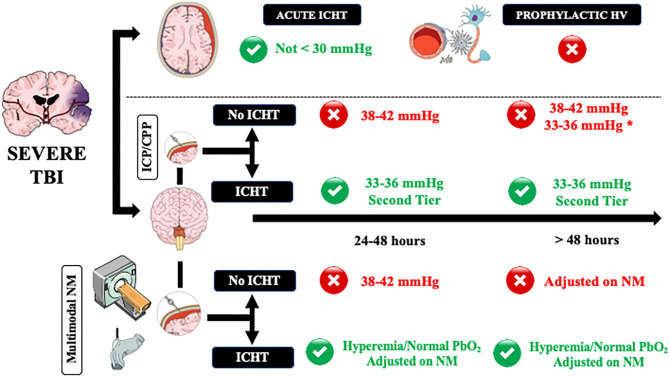
A practical approach on how to manage controlled hyperventilation and hypocapnia in traumatic brain injury (TBI) patients. Acute intracranial hypertension (ICHT) = life-threatening elevation in ICP, in particular when signs of herniation (i.e., anisocoria, apnea, hypertension, bradycardia) are present. ICHT, intracranial pressure close to the critical threshold for therapy without signs of herniation; HV, controlled hyperventilation and hypocapnia. Green and red circles refers to the potential use (green) or contraindication (red) to the use of HV. NM, neuromonitoring. *In case of diffuse brain injury but with high potential risk of tissue hypoxia. **Adjusted on neuromonitoring.